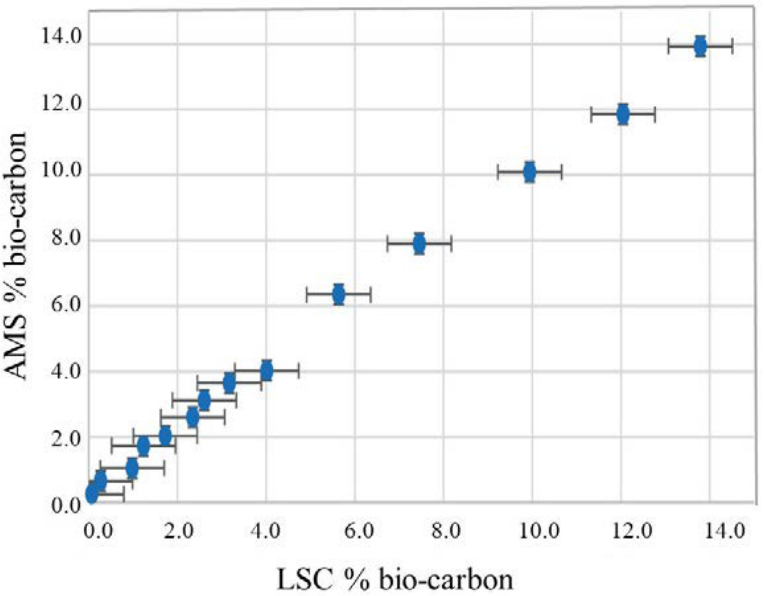
Figure 4. Comparison between AMS and LSC measurement for gasoline with repeatability error bars (source: [55]).